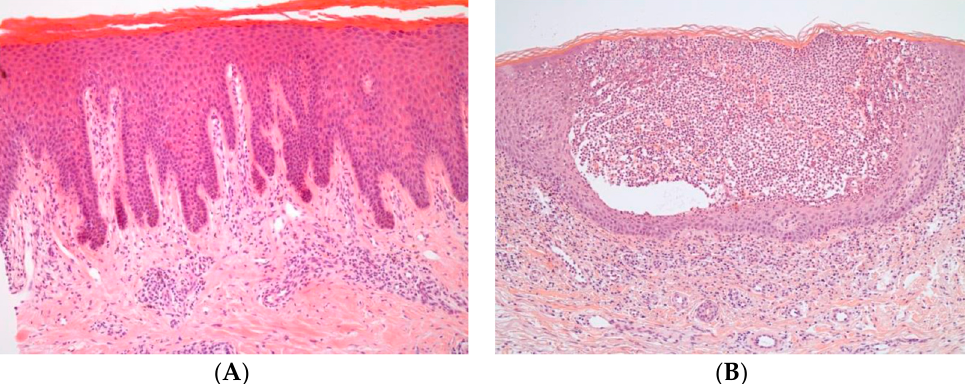
Figure 4. Histopathology of psoriasis. ( A ) Psoriasis vulgaris characteristically shows acanthosis, parakeratosis, and dermal inflammatory infiltrates. ( B ) In pustular psoriasis, acanthotic changes are accompanied by epidermal predominantly neutrophilic infiltrates, which cause pustule formation.